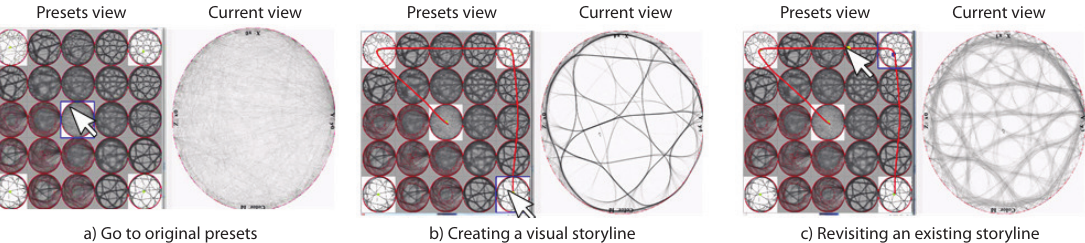
Figure 4. (a–c ) Three different types of navigation of the view